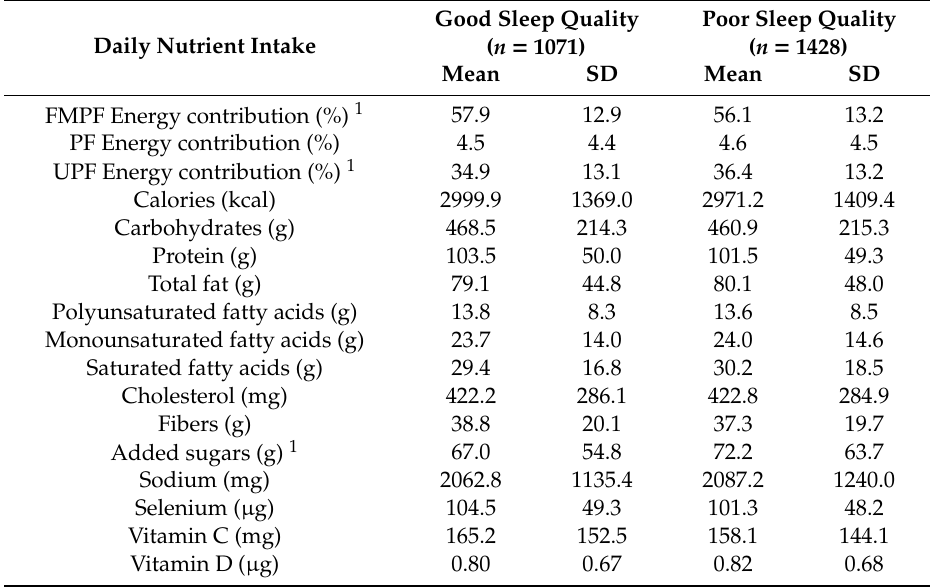
Table 2. Daily nutrient intake according to sleep quality in adolescents from S ã o Lu í s, Maranh ã o, Brazil, 2016.